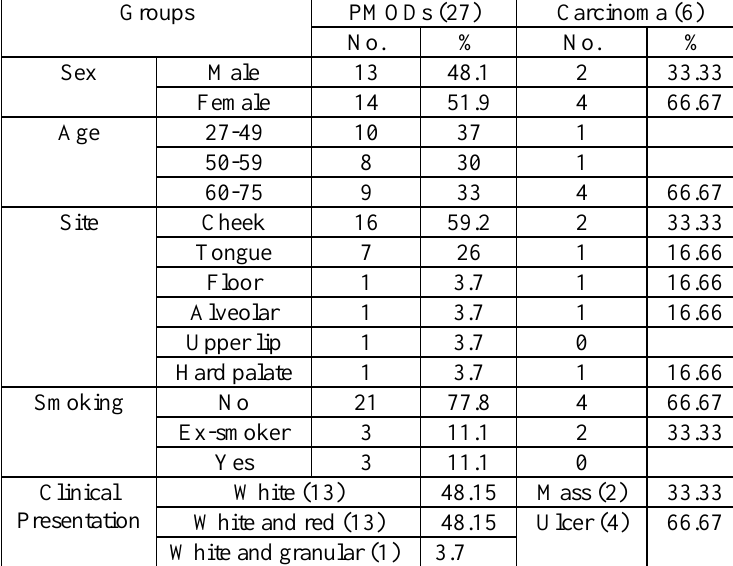
Figure 3: Immunohistochemical expression of Wnt3. (a) alveolar mucosa. (b) gingival mucosa .(c) oral lichen planus without dysplasia. (d) oral lichen planus with mild dysplasia. (e&f) leukoplakia with dysplasia. (g) OSCC.(h) proliferative verrucous leukoplakia. (X100 for all pictures except F, X 400). Table (1): Clinical characteristics of